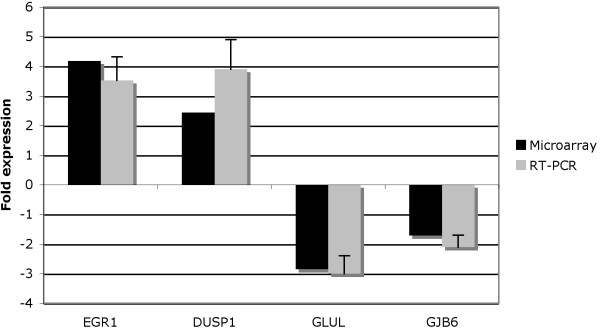
Comparison of microarray and real-time PCR experiments. For 4 genes modulated in shGATA3 cells, microarray ratios were compared to real-time PCR ratios. The given ratios are the expression levels of irradiated compared to non-irradiated cells. RT-PCR ratios are the means of 3 independent amplifications. Errors bars correspond to standard deviations.